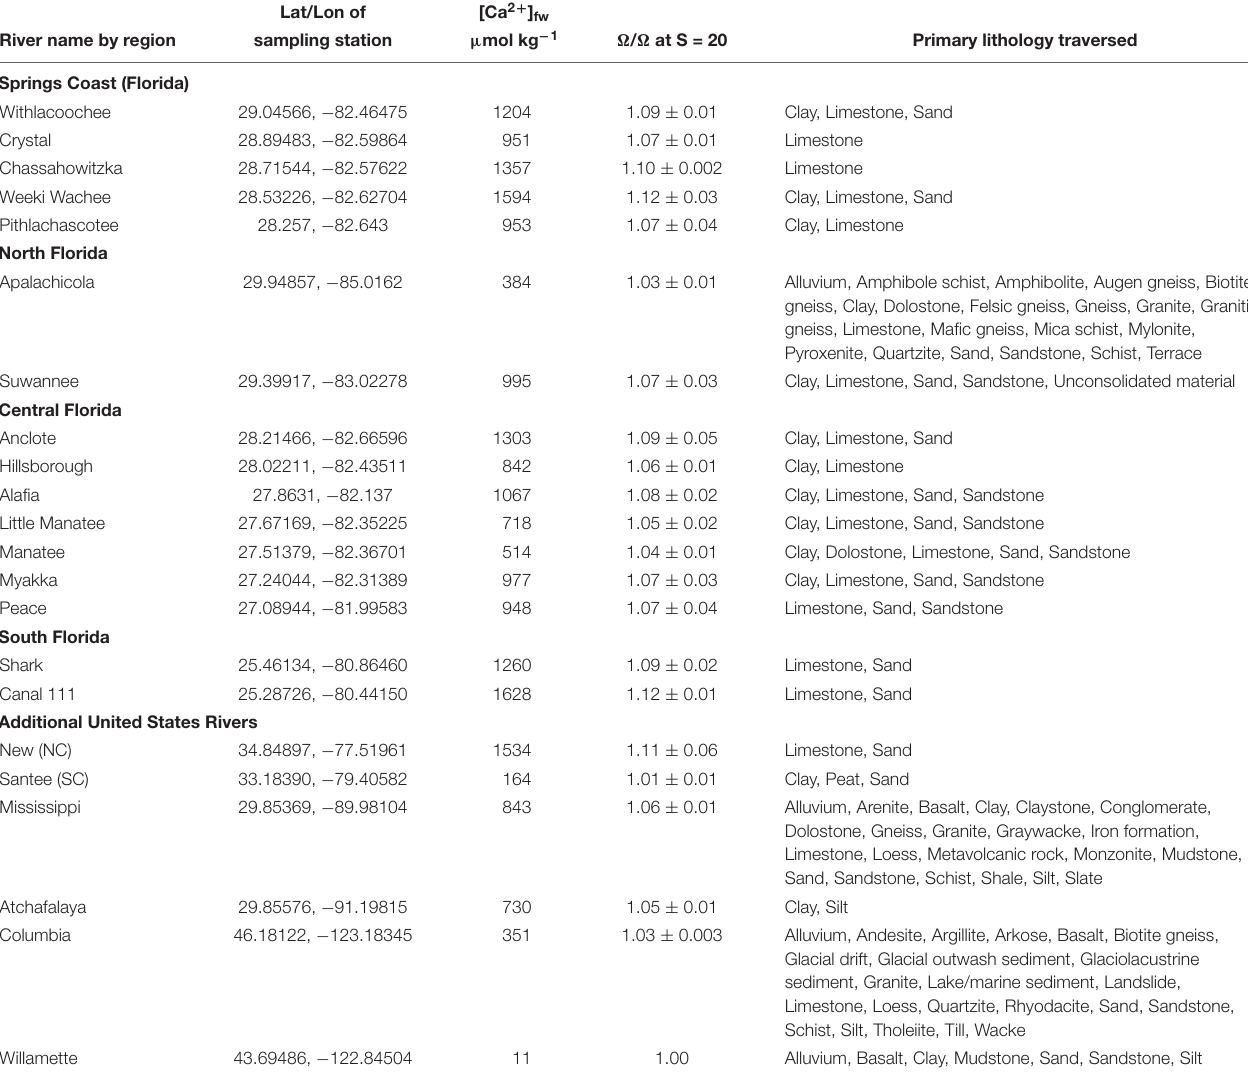
TABLE 1 | Freshwater calcium end-members, lithology, and (cid:127) -ratios of rivers in this study. Lat/Lon